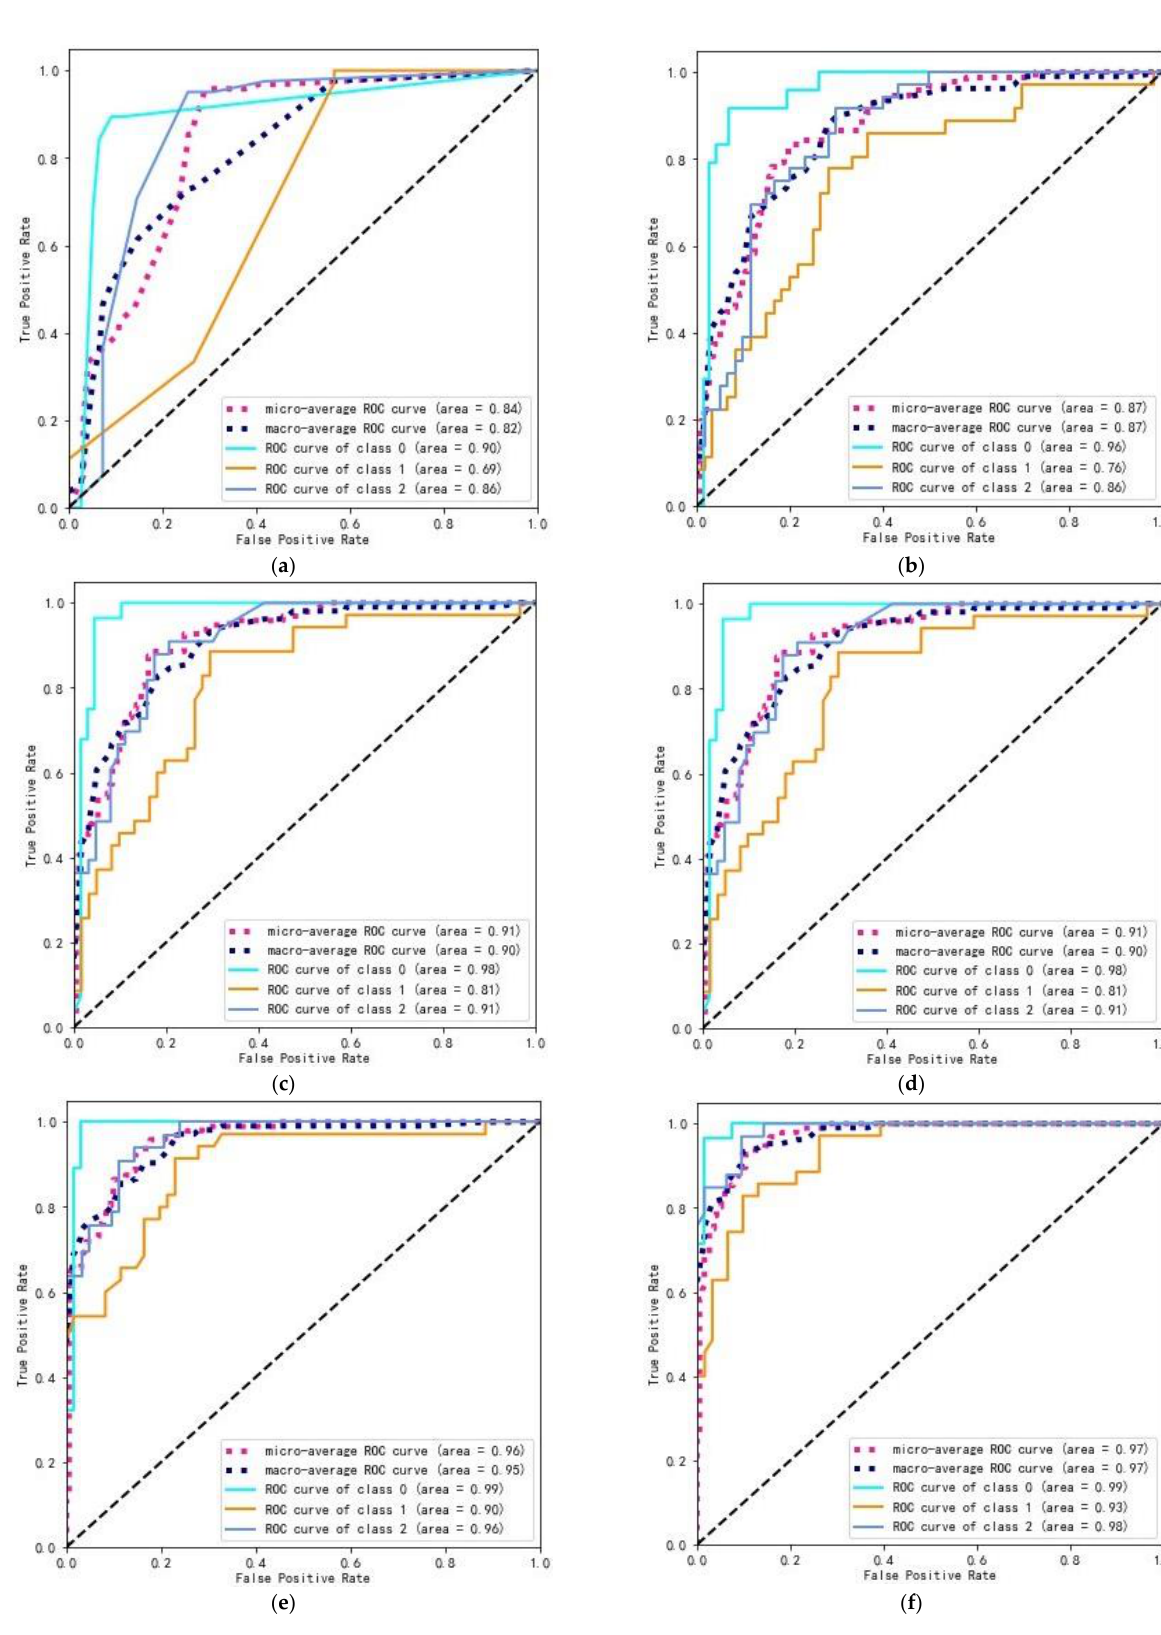
Figure 5. ROC plot of ( a ) decision tree; ( b ) XGBoost; ( c ) random forest; ( d ) LightGBM; ( e ) bagging fusion model; ( f ) stacking fusion model.